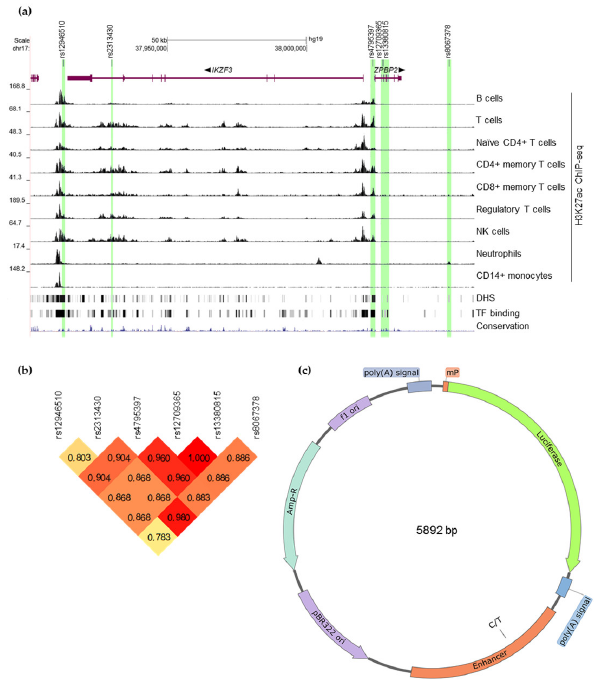
Figure 1. Candidate functional SNPs in the human autoimmunity-associated locus 17q12-21 and the corresponding putative enhancers. ( a ) University of California Santa Cruz (UCSC) Genome Browser [51,52] view of the candidate functional SNPs (black lines) associated with autoimmune diseases in the 17q12-21 locus and the corresponding putative enhancers (highlighted in green). Histone acetylation tracks provided by ENCODE [53,54] illustrate enhancer activity in a variety of primary human leukocytes. Gene schemes are shown in purple. Thin lines correspond to introns, thicker parts correspond to exons with coding sequences being the thickest. Direction of transcription is indicated by arrows next to gene names. DHS—DNaseI hypersensitivity clusters in 125 cell types from ENCODE (V3). TF binding—ChIP-seq peaks for 161 transcription factors in 91 cell types from ENCODE. ( b ) Linkage disequilibrium between candidate SNPs (r 2 in CEU (Utah Residents with